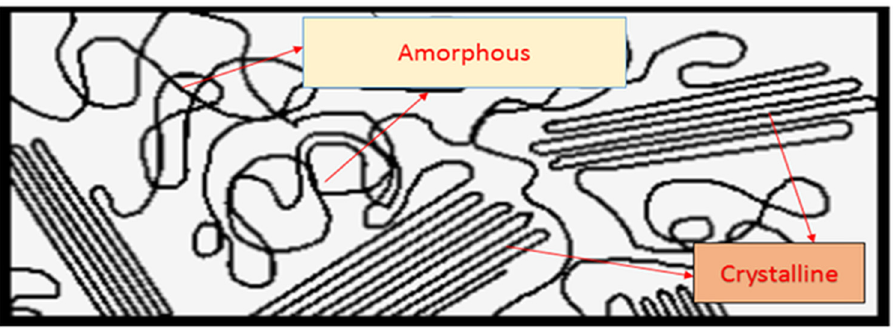
Figure 5: Schematic diagram of polymer representing crystalline and amorphous domains.